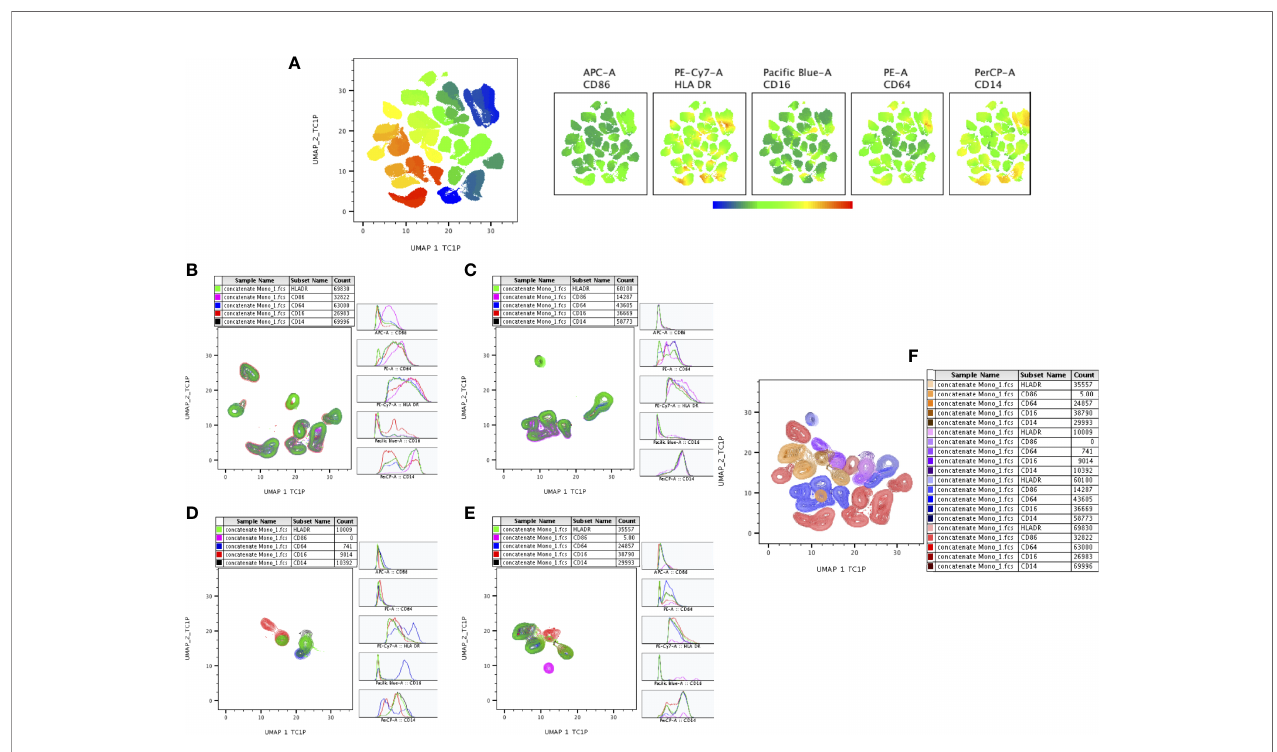
FIGURE 6 | UMAP analysis of monocyte subsets. CD16 + HLADR + (7,000 cells) were down sampled from monocytes and performed (A) unsupervised (UMAP (UMAP_1_TC1P vs UMAP_2_TC1P) clusters (ungated) and expression of individual monocytes (CD86, HLADR, CD14, CD16, CD64) markers between the study (DR-TB, DS- TB, LTB, HC) population. (B – E) represents the DR-TB, DS-TB, LTB, HC group expression of monocyte marker (islands) subsets using contour plots. (F) shows merged contour plot expression of monocyte subsets among the study